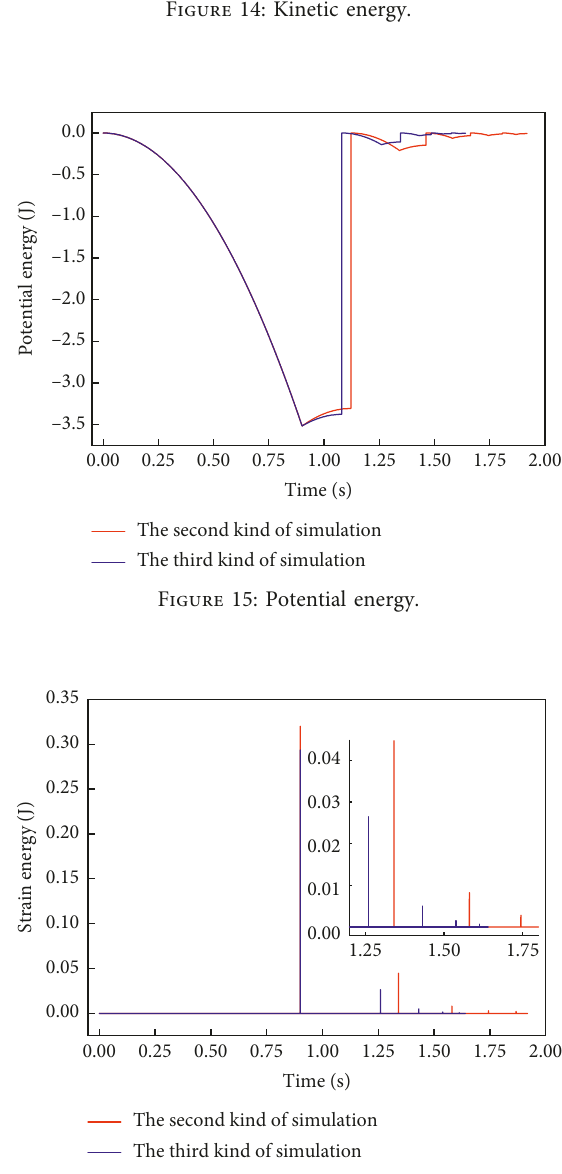
Figure 16: Strain energy.